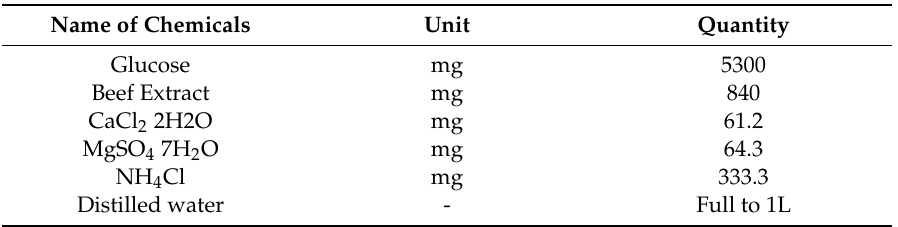
Table 2. Composition of the synthetic wastewater.